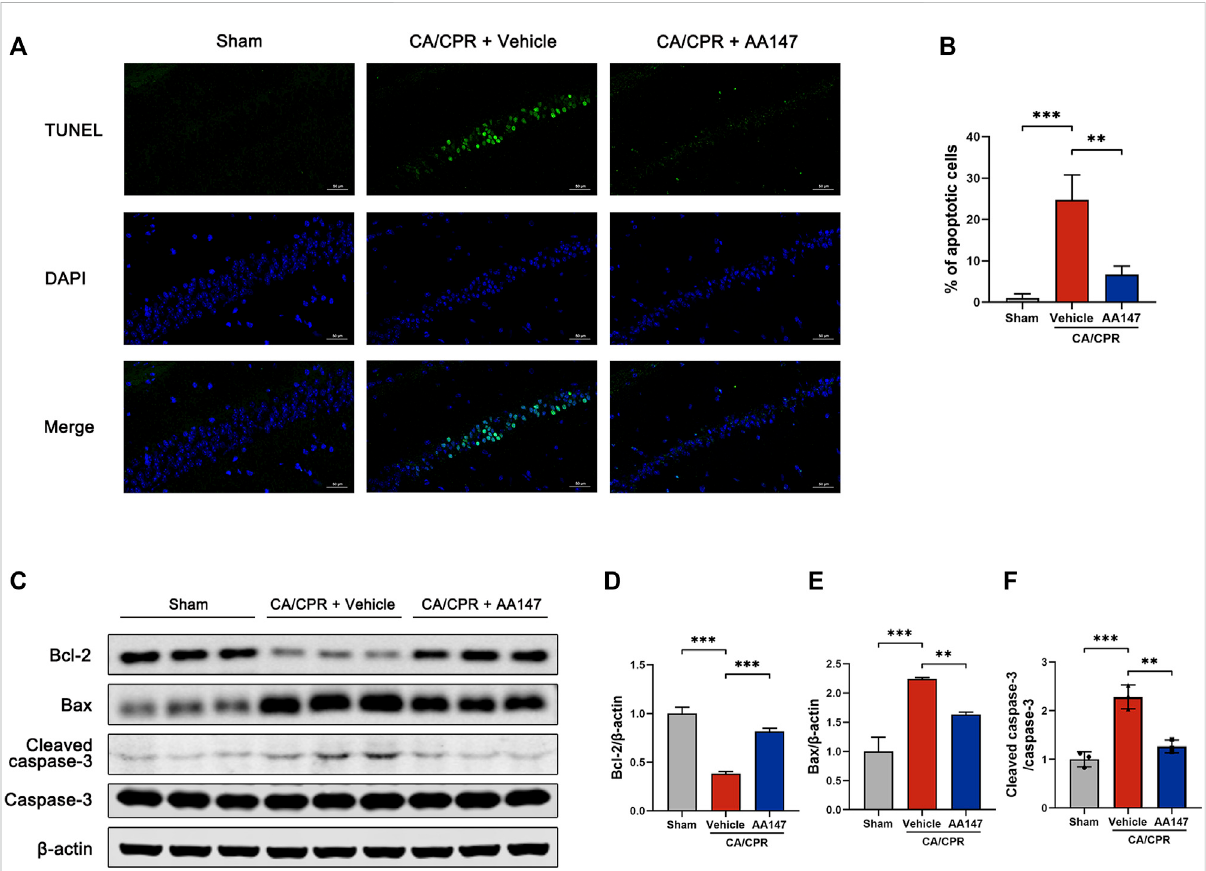
FIGURE 3 AA147 alleviated neuronal apoptosis induced by cardiac arrest and cardiopulmonary resuscitation (CA/CPR). Mice were subjected to sham or CA/CPR surgery. The brain tissue samples were collected for the TUNEL assay at 3 days after CA/CPR, and the hippocampus of mice that were sacri fi ced at 1 day after CA/CPR were used for western blot assay. (A) TUNEL staining of the hippocampal CA1 sub fi eld and (B) quanti fi cation of the apoptotic neurons. Numerous TUNEL + cells were observed in the hippocampus of mice in CA + Vehicle group, while treatment with AA147signi fi cantlyreducedthecountsofTUNEL + cells.Scalebar=50 μ m. (C) Westernblotassayofapoptosis-relatedproteins: (D) Bcl-2, (E) Bax, (F) cleaved-caspase-3,andcaspase-3.The increased CA/CPR-induced apoptotic signalswerereducedbyAA147. Data aredisplayed asmean± SD( n